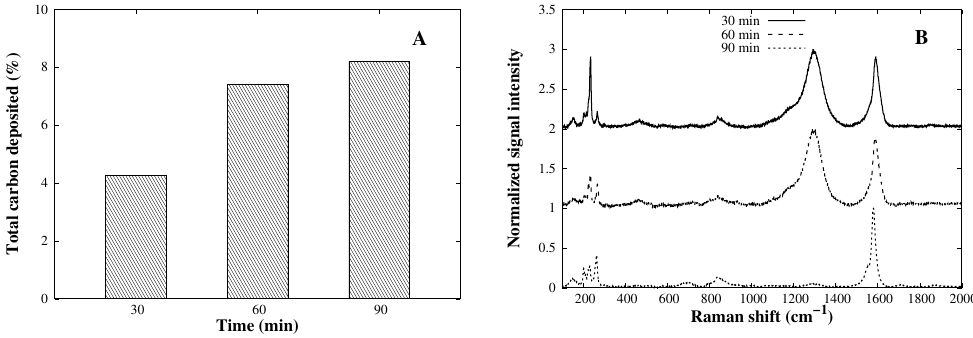
Figure 5. ( A ) Time effect on carbon deposition amount and ( B ) Raman characteristics of CVD deposition products as function of